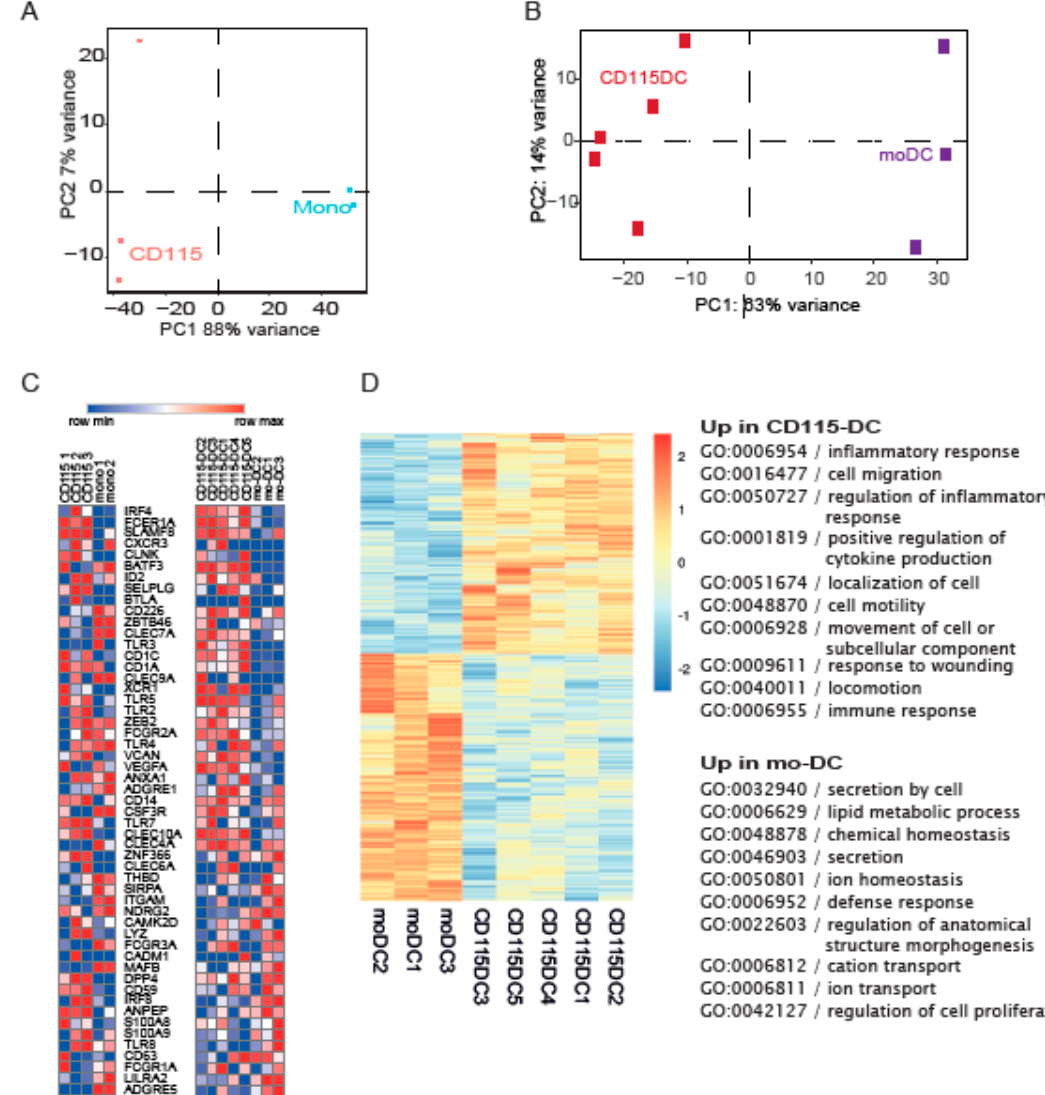
Figure 5. RNA sequence reveals different genetic profiles within the progenitors and DCs. ( A – D ) RNA-seq data from monocytes, CD115 progenitors, mo-DCs, and CD115-DCs. ( A ) PCA plot of the CD115 progenitors sorted after 7 days of expansion compared to CD14-isolated monocytes. ( B ) PCA of CD115-DCs compared to IL-4/GM-CSF-cultured CB-derived mo-DCs. ( C )